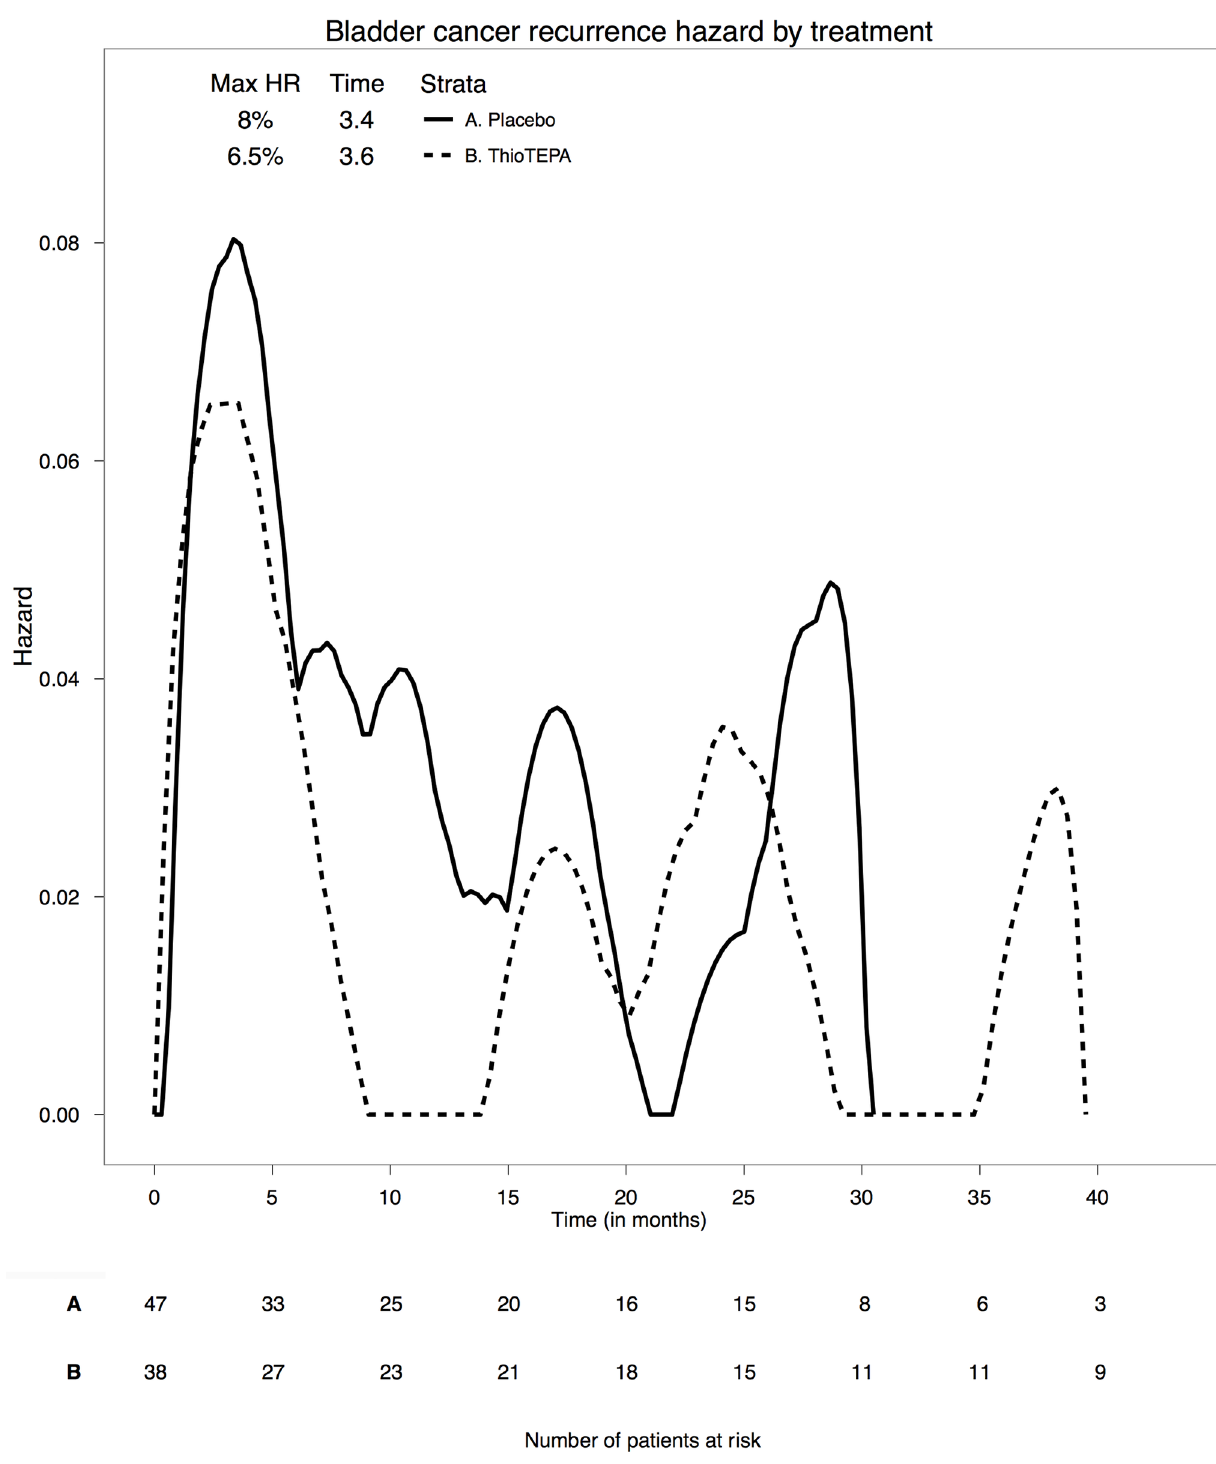
Fig 4. Comparison of two hazard functions. The graph is followed by the number of patients at risk.